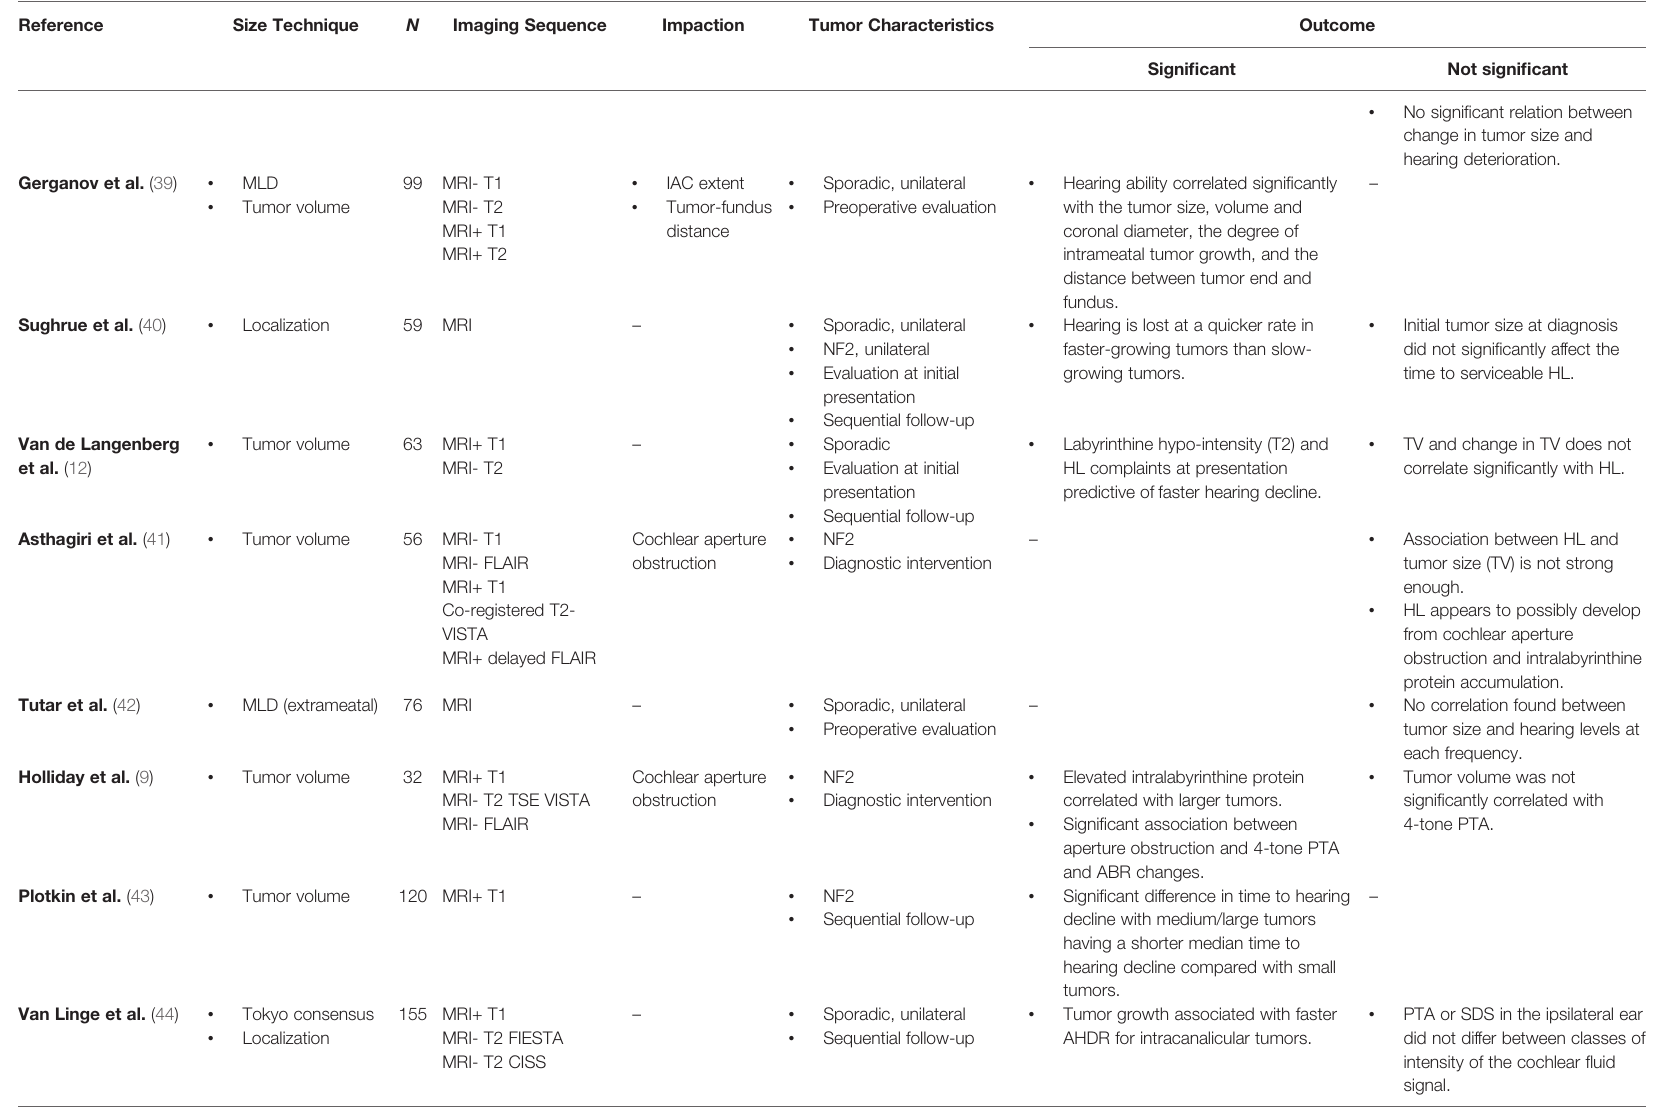
intensity of the cochlear fl uid